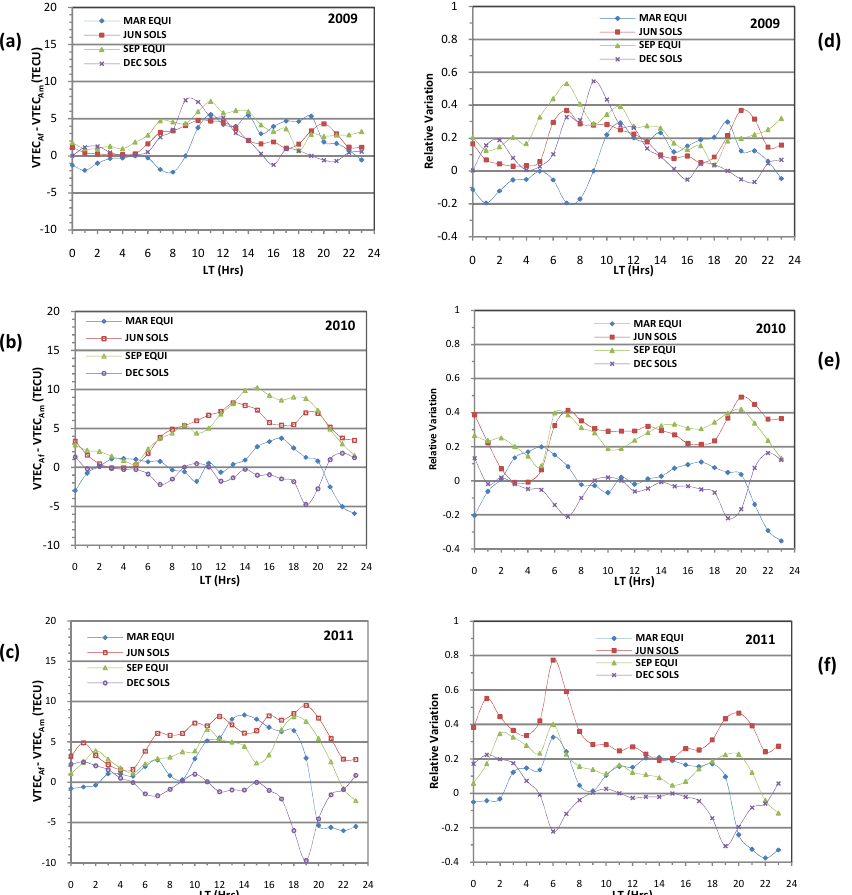
Fig. 2 . Seasonal deviations of the mean VTEC values at Pucallpa from those at Lagos, during (a) 2009 (b) 2010, and (c) 2011. Corresponding relative variations during (d) 2009 (e) 2010, and (f) 2011.